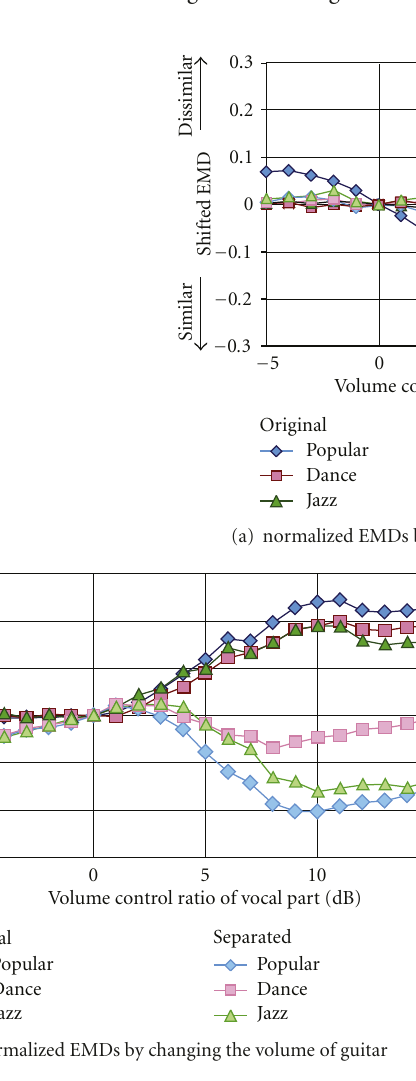
Figure 8: Normalized EMDs that are shifted to 0 when the volume control ratio is 0dB for each genre while reducing or boosting the volume. (a), (b), and (c) graphs are obtained by changing the volume of the vocal, guitar, and drum parts, respectively. Note that a smaller EMD plotted in the lower area of each graph indicates higher similarity than the one without volume controlling. (a) Normalized EMDs by changing the volume of vocal. (b) Normalized EMDs by changing the volume of guitar. (c) Normalized EMDs by changing the volume of